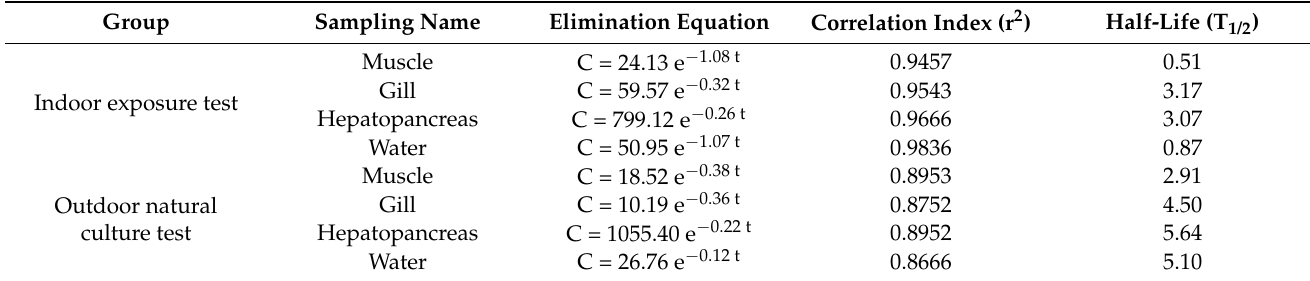
Table 8. Elimination equation, correlation index, and half-life of pendimethalin in P. clarkii tissues and water.